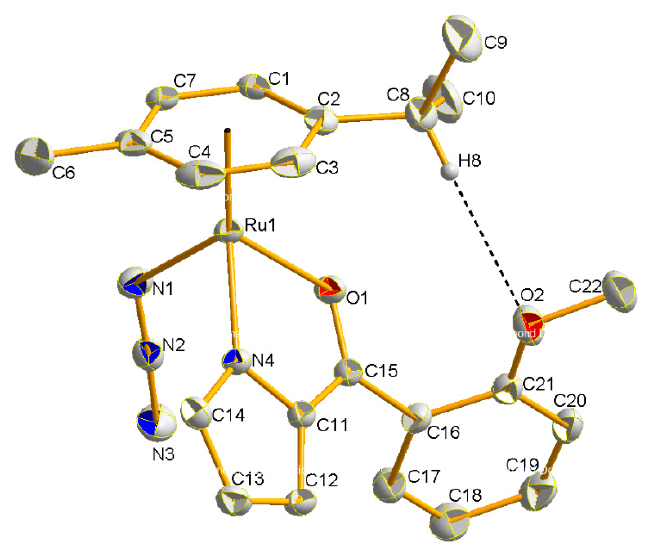
Figure 4. The molecular geometry of Compound 5 . The thermal ellipsoids were drawn at 50% probability and all the hydrogen atoms except the methine proton on the cymene ring were omitted for clarity. The H8-O2 hydrogen bonding is shown.